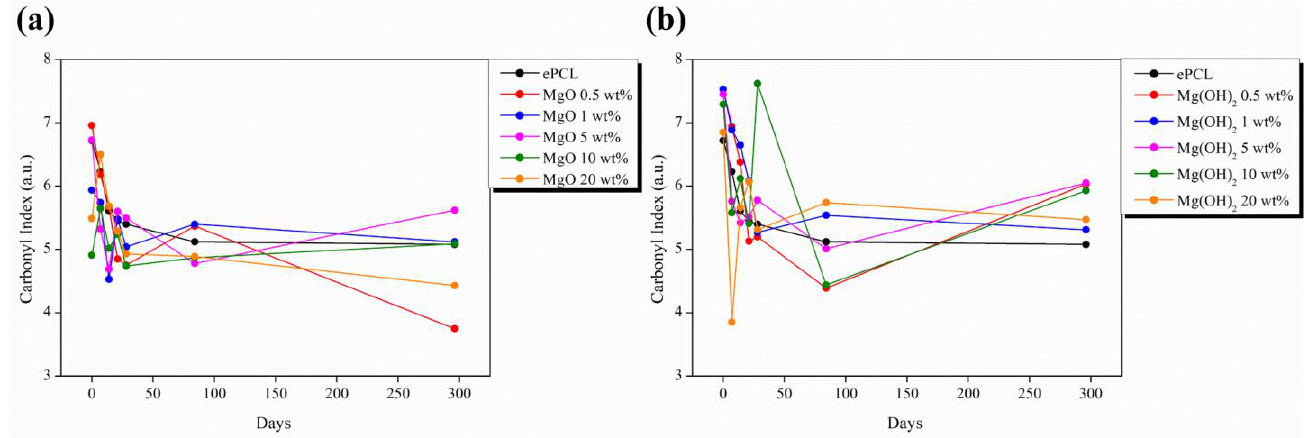
Figure 9. Carbonyl index of ( a ) ePCL + MgO NPs and ( b ) ePCL + Mg(OH) 2 NPs.